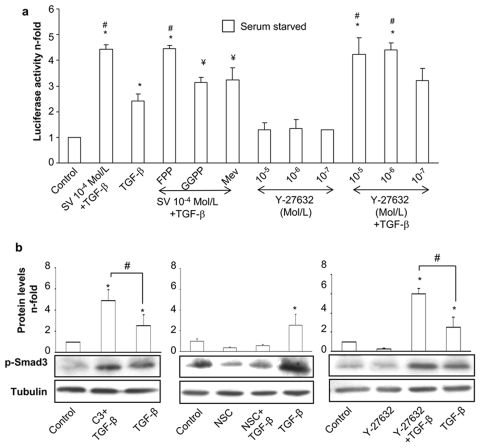
RhoA/ROCK inhibition increases the TGF-β/Smad pathway.a. VSMCs, grown in serum-free medium, were transfected with a Smad-luc reporter vector for 24h. Then, cells were treated for 24h with Simvastatin (SV) or Y-27632. After that, 1 ng/mL TGF-β was added in fresh medium and Smad-dependent transcription was measured after 24h of incubation. Some cells were pretreated for 1h with 5 µg/mL FPP or GGPP or 10−4 mol/L mevalonate (Mev) before Simvastatin treatment. Luciferase activity is expressed as mean±SEM of 4 experiments. *p<0.05 vs. control. ¥ p<0.05 vs. SV 10−4 Mol/L. b: Serum starved VSMCs were incubated for 48h with C3 exoenzyme (10 µg/mL), NSC-23766 (50mMol/L) or Y-27632 (10−5 mol/L), before stimulation with TGF-β for 20 min. Representative western blot and relative protein levels expressed as mean±SEM of 4 experiments. *p<0.05 vs. control. # p<0.05 vs. TGF-β.